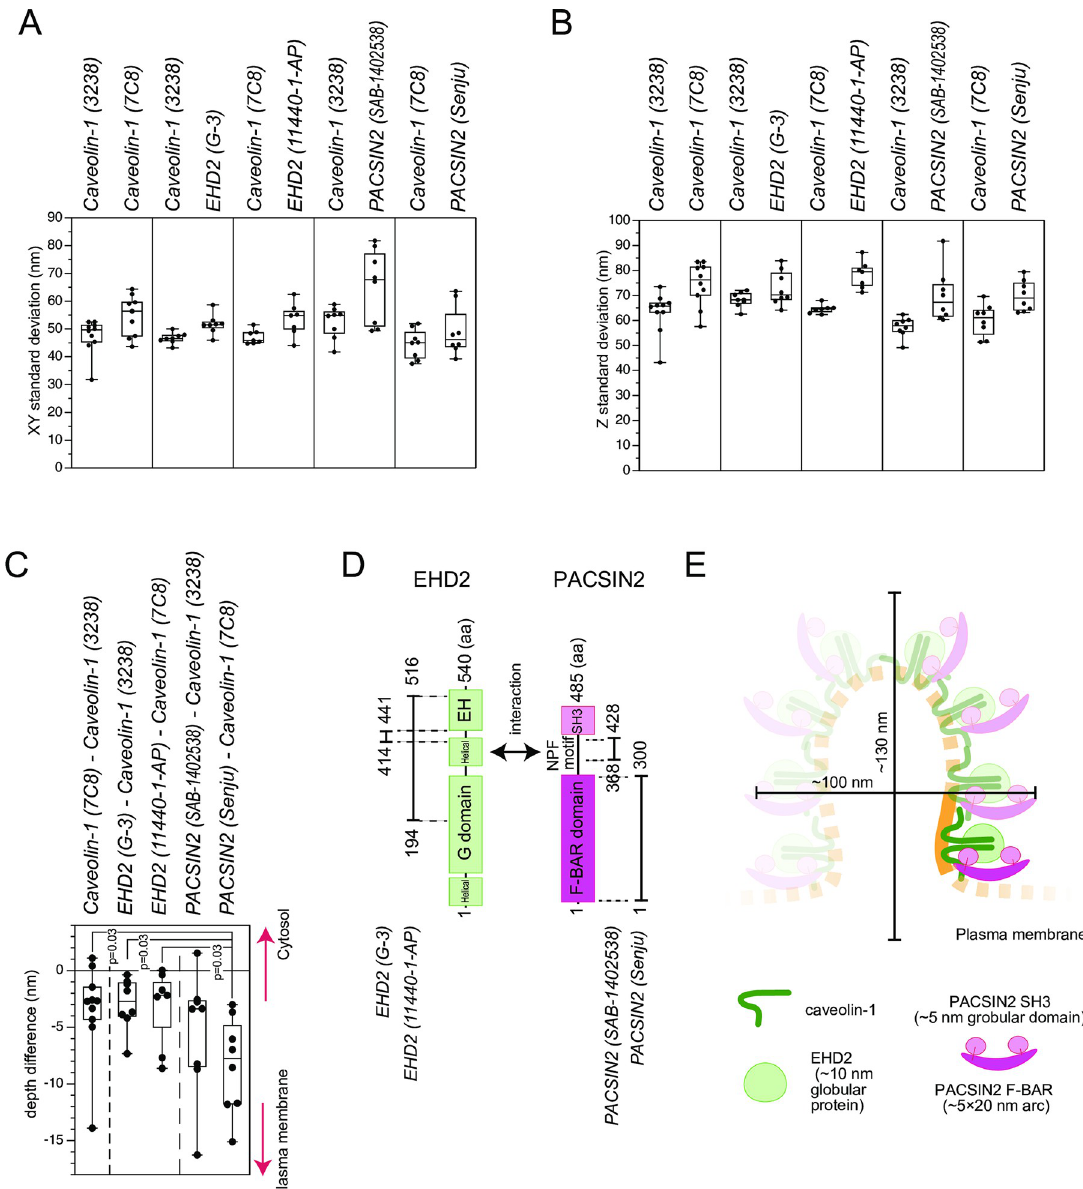
Fig 3. The geometry of colocalization in the blobs. (A) Standard deviations of the blobs of each antibody staining in the XY plane, the plane parallel to the lens surface or coverslip of the cell attachment; i.e., the plasma membrane. (B) Standard deviations of the blobs of each antibody staining in the Z or depth direction. In (A, B), the pairs of antibodies used for co-staining are shown side-by-side. The dot represents an average from an observation, which typically contained a cell. N = 6–10 observations for each combination of antibodies. (C) The difference in the blob centroid depths of the indicated antibodies used for co-staining. A negative value indicates closer localization to the plasma membrane. The dot represents an average from an observation, which typically contained one cell. N = 6–10 observations for each combination of antibodies. The statistical difference in the depth of the PACSIN2 antibodies was evaluated by one- way ANOVA with post-hoc Holm-Bonferroni analysis and the p-values were indicated. (D) Domain diagrams of PACSIN2 and EHD2. The antigens for the antibodies, as well as the interaction sites between PACSIN2 and EHD2, are also illustrated. (E) A model of PACSIN2 F-BAR domain localization in caveolae. The PACSIN2 F-BAR domain, SH3 domain, EHD2, and caveolin-1 are illustrated in an approximate scale. The size of the caveola is obtained from ~2 times of the standard deviations. The PACSIN2 F-BAR domain is located close to the plasma membrane, but PACSIN2, EHD2, and caveolin-1 mostly overlap each other, resulting in the hypothetical unit of PACSIN2, EHD2, and presumably caveolin-1 in caveolae. The shaded part is hypothetical.